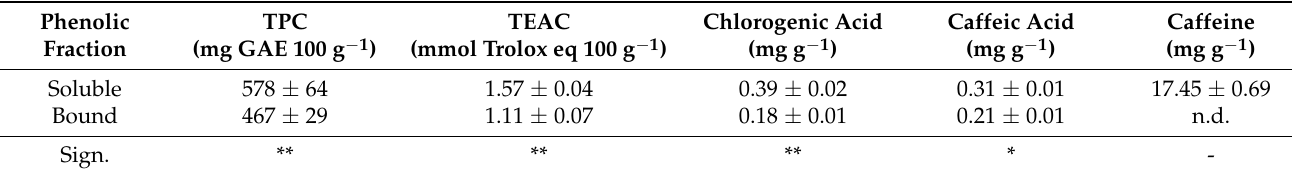
Table 3. Total polyphenol content (TPC), caffeic and chlorogenic acids, caffeine content, and radical-scavenging activity (TEAC) in CSS.